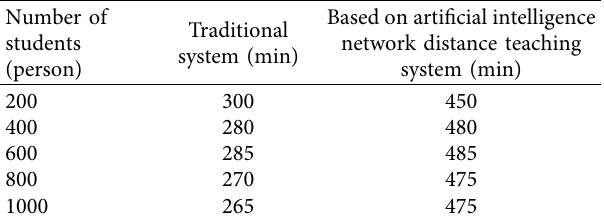
Table 2: Comparative analysis of the scores obtained in distance teaching by two methods.